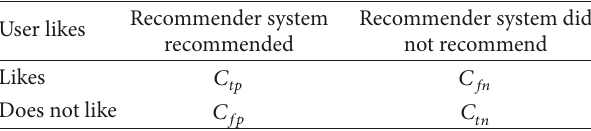
Table 2: The four cases of the unselected objects of the target user in the recommender